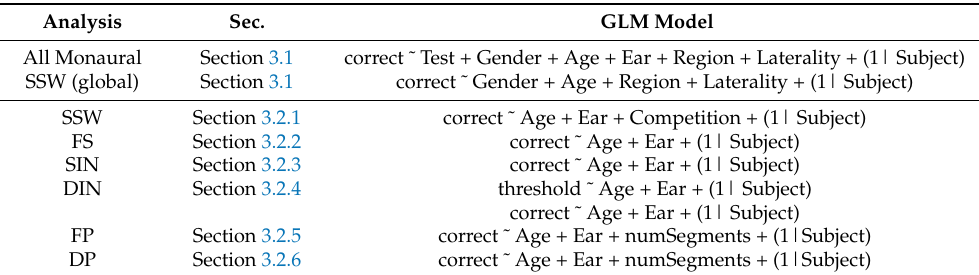
Table 3. Information regarding the Generalized Linear Models (GLM) models used for the analyses of the auditory